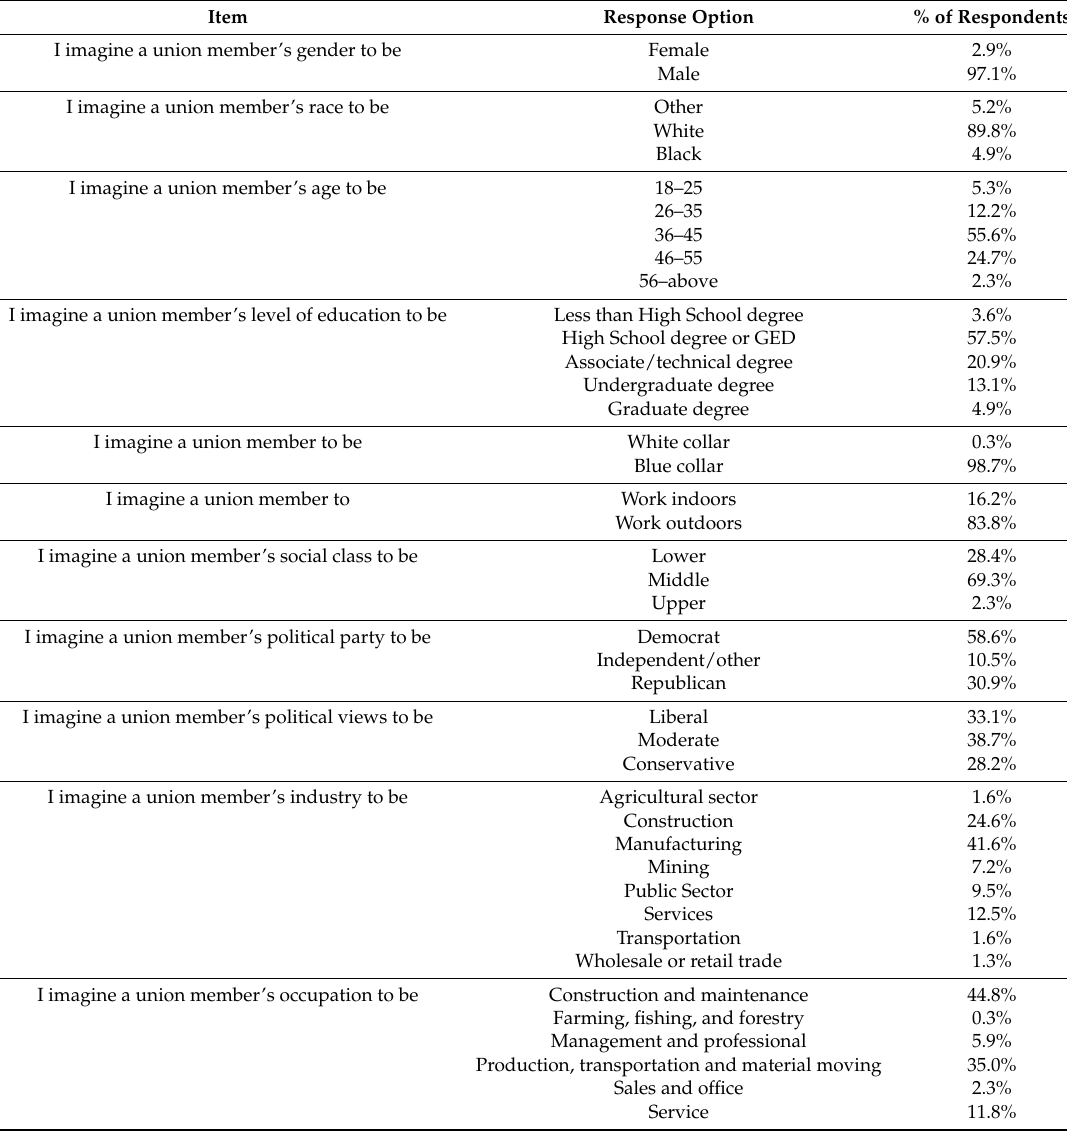
Table 1. Demographics of Imagined Union